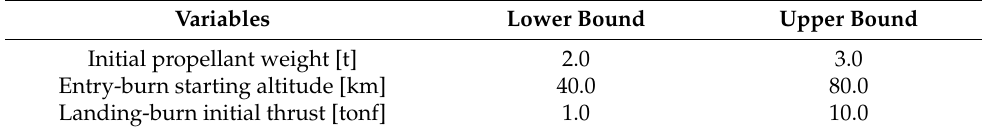
Table 9. Variables and